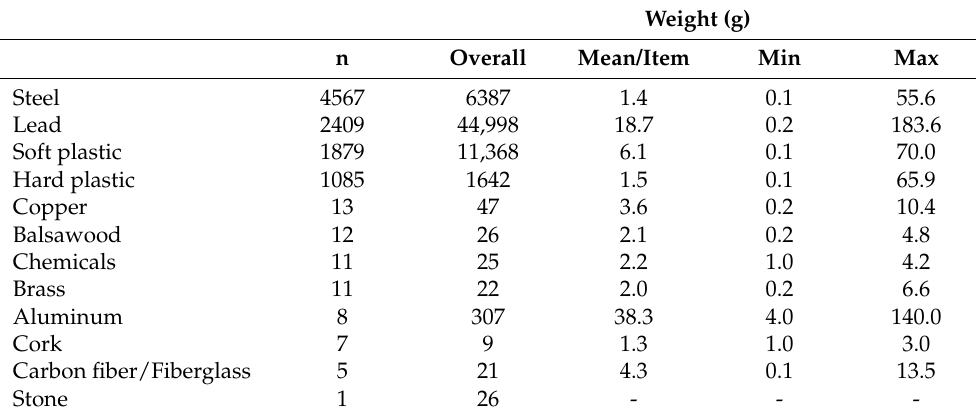
Table 2. Identified components of lost fishing tackle found in Lake Eixendorf. Note that some of the materials, e.g., “steel”, can consist of several components including zinc or nickel. The same holds true for fishing lines that can consist of either polyamide, polyethylene, or other polymers. Mean = mean weight per item, min = minimum weight per item, max = maximum weight per item, n = number of items containing the substance. Weight (g) n Overall Mean/Item